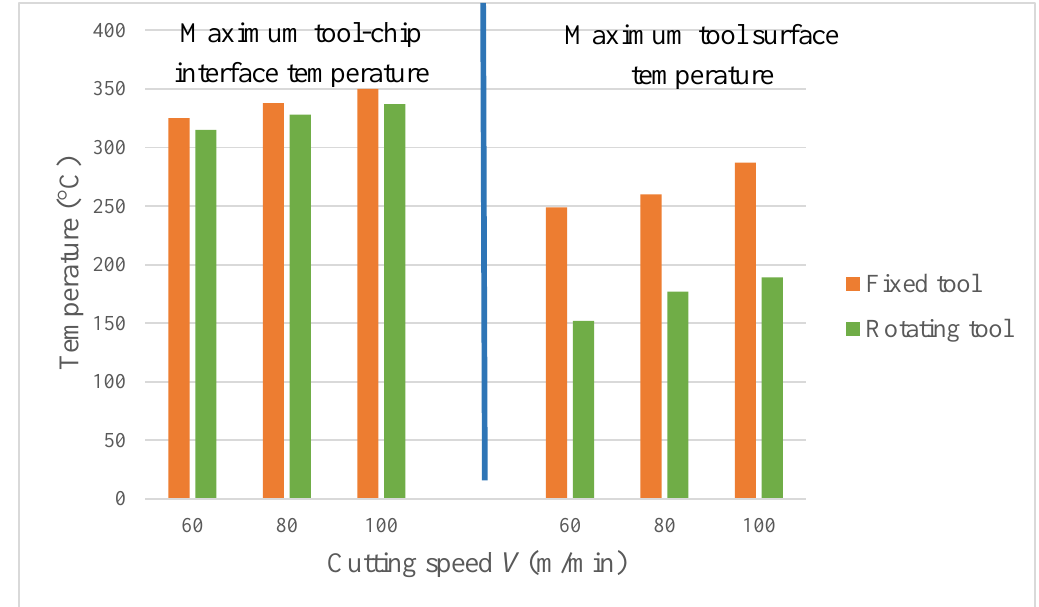
Figure 7. Maximum tool-chip interface and tool surface temperatures at varying cutting speeds for the fixed and rotating tool.